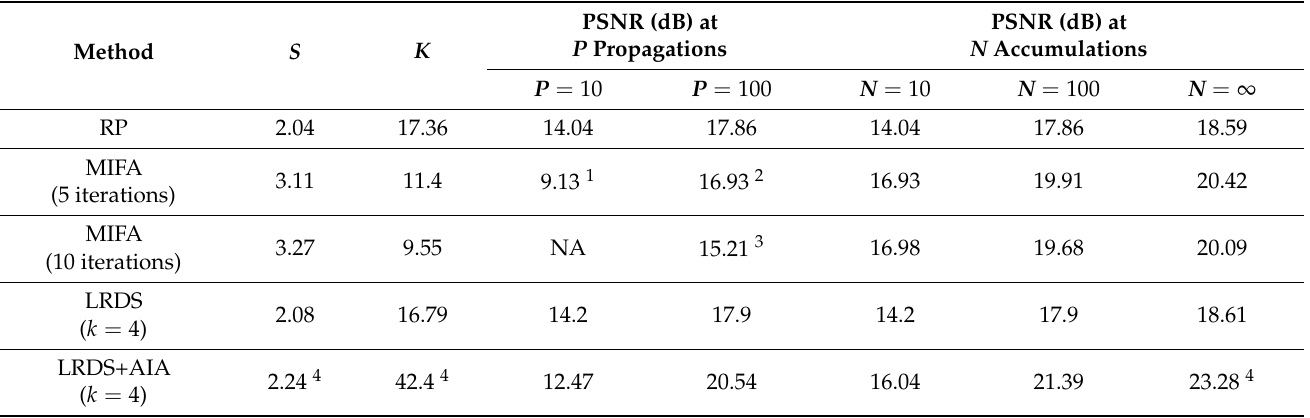
Table 1. Comparison of different binary CGH